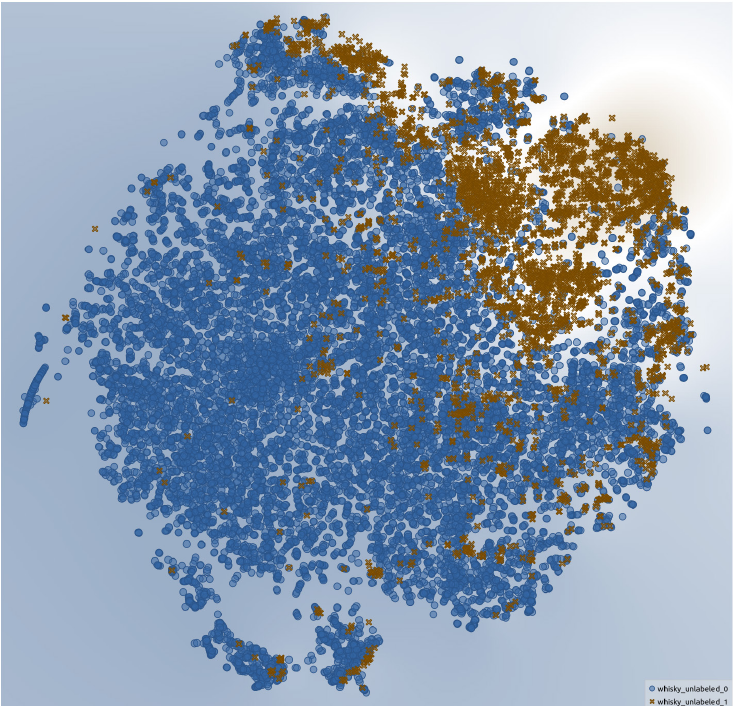
Figure 8 : Application of trained model to the corpus (minus the training and test set). Brown “X”’s represent a word labeled as a descriptor and blue dots are labeled as